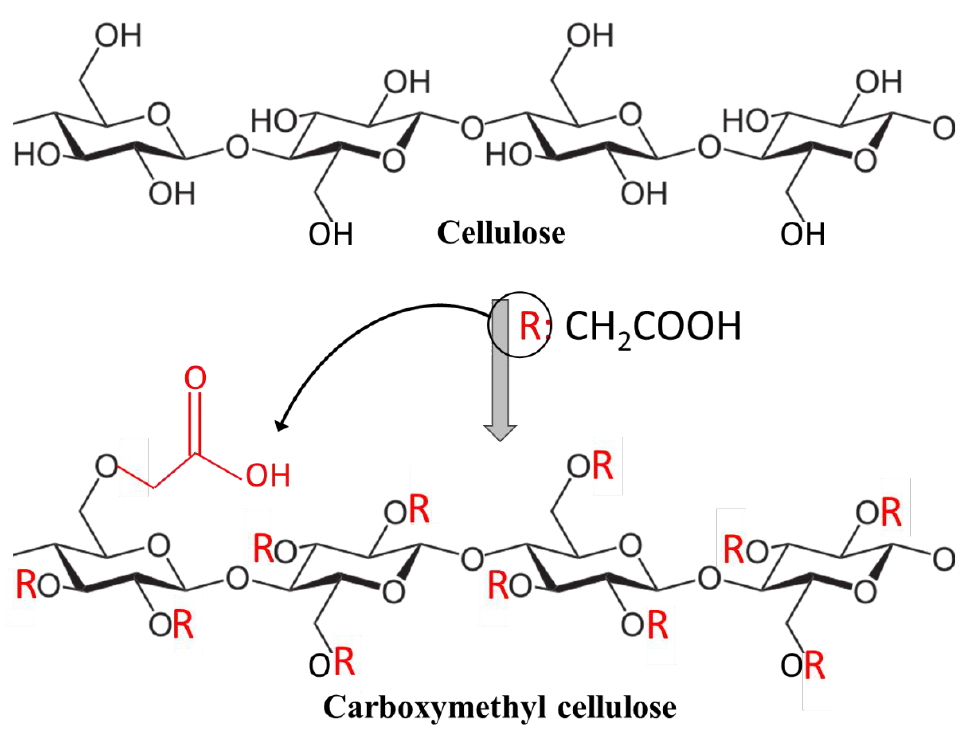
Figure 2. Chemical structure of cellulose and carboxymethyl cellulose.